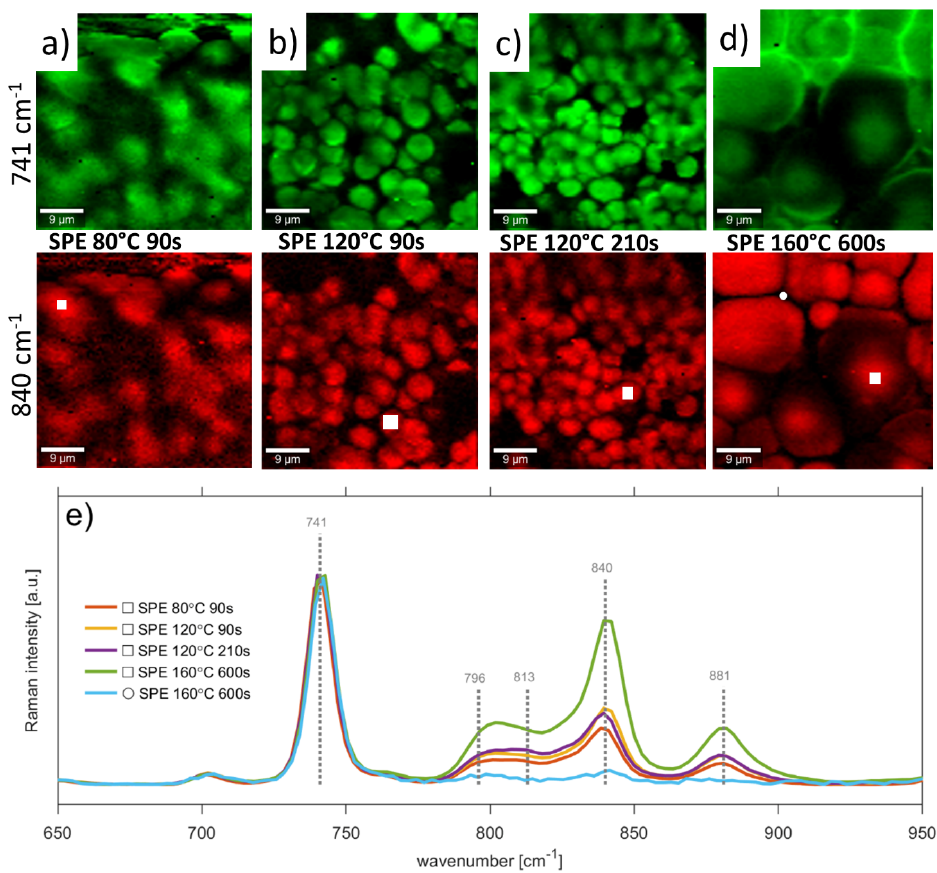
Figure 3. Raman maps for peaks 741 cm − 1 (ionic liquid), 840 cm − 1 (PVDF) for SPEs prepared at ( a ) 80 °C 90 s ( b ) 120 °C 90 s ( c ) 120 °C 210 s and ( d ) 160 °C 600 s ( e ) normalized Raman spectra corre- sponding to area of small white squares and white circle on SPEs. Peaks were normalized at 741 cm − 1 . White squares are located on spherulites, while circle is located between them (amorphous region).